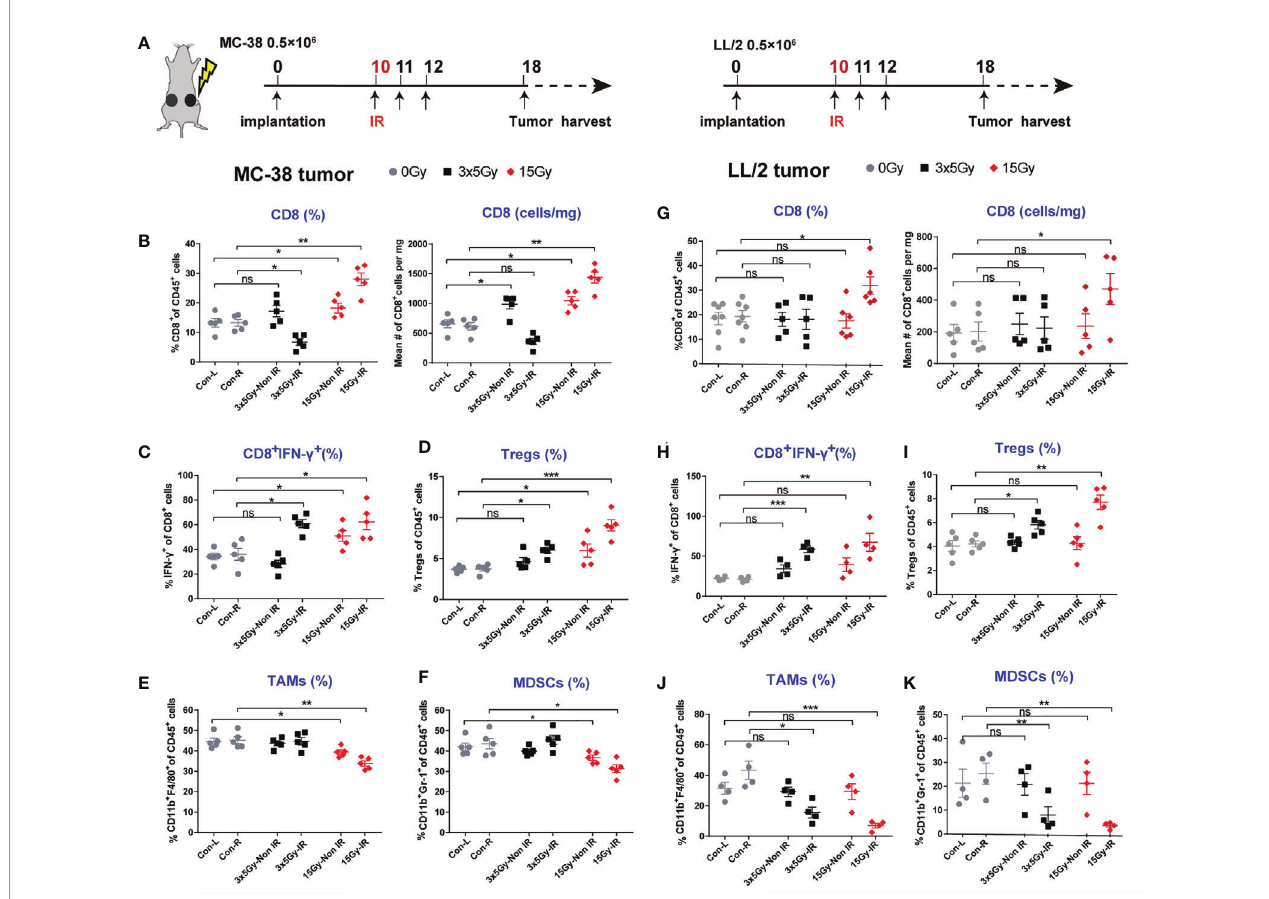
FIGURE 3 | Alteration of the tumor immune microenvironment induced by radiation in highly and poorly immunogenic tumors. (A) Tumor-in fi ltrating immune cells from MC-38 and LL/2 tumors that received 3 × 5 Gy, 15 Gy or sham radiation were analysed 8 days after radiation by fl ow cytometry. (B) Percentages and absolute numbers of CD8 T cells (gating CD45 + immune cells) are presented for the MC-38-irradiated and non-irradiated tumors. (C) Tumor-in fi ltrating T cells were stimulated with PMA and ionomycin in vitro , and then the percentages of CD8 + IFN- g + cells were detected in irradiated and non-irradiated MC-38 tumors. (D – F) Percentages of Tregs, MDSCs and TAMs in the irradiated and non-irradiated MC-38 tumors. (G) Percentages and absolute numbers of CD8 T cells in the LL/2-irradiated and non- irradiated tumors. (H) Percentages of CD8 + IFN- g + cells in the LL/2 tumors. (I – K) Percentages of Tregs, MDSCs and TAMs in the LL/2-irradiated and non-irradiated tumors. IR, irradiated sides; Non IR, contralateral non-irradiated sides. Representative results from one of at least two independent experiments are shown. * p < 0.05, ** p < 0.01, *** p < 0.001, ns, no signi fi